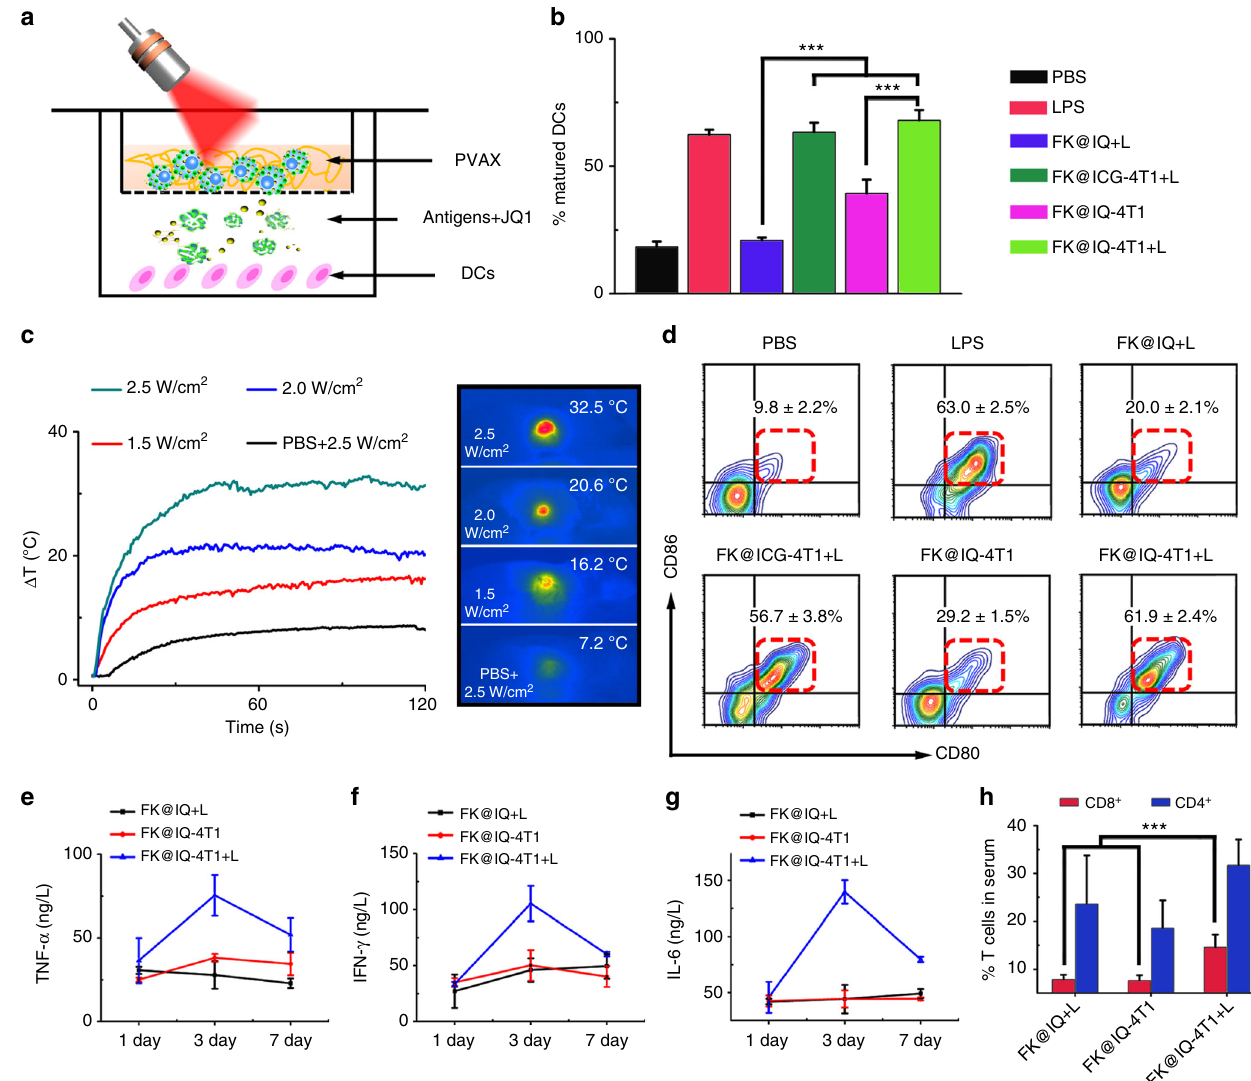
Fig. 3 PVAX promoted DC maturation and induced immune response in vitro and in vivo. a Transwell co-culture set-up for inducing dendritic cell (DC) maturation in vitro. b PVAX-induced DC maturation (CD11c + CD80 + CD86 + ) in vitro, the vaccines was illuminated with 808 nm laser for 2.0 min at a photodensity of 2.0 W/cm 2 . Unpaired student ’ s t -test (two-tailed) was used for comparison between two groups. *** p < 0.01. Data represent mean ± s.d. ( n = 3). c Photothermal effect of FK@IQ-4T1 vaccine in vivo. d The frequency of mature DCs (CD11c + CD80 + CD86 + ) in draining LNs of BALB/c mice upon different treatments. Data represent mean ± s.d. ( n = 3). e , g Serum concentrations of e TNF- α , f IFN- γ , and g IL-6 examined at the desired time points post treatment. h The frequency of serum CD8 + and CD4 + T cells examined 3 days post the indicated treatments. Unpaired student ’ s t -test (two-tailed) was used for comparison between two groups. *** p < 0.01. Data represent mean ± s.d. ( n =